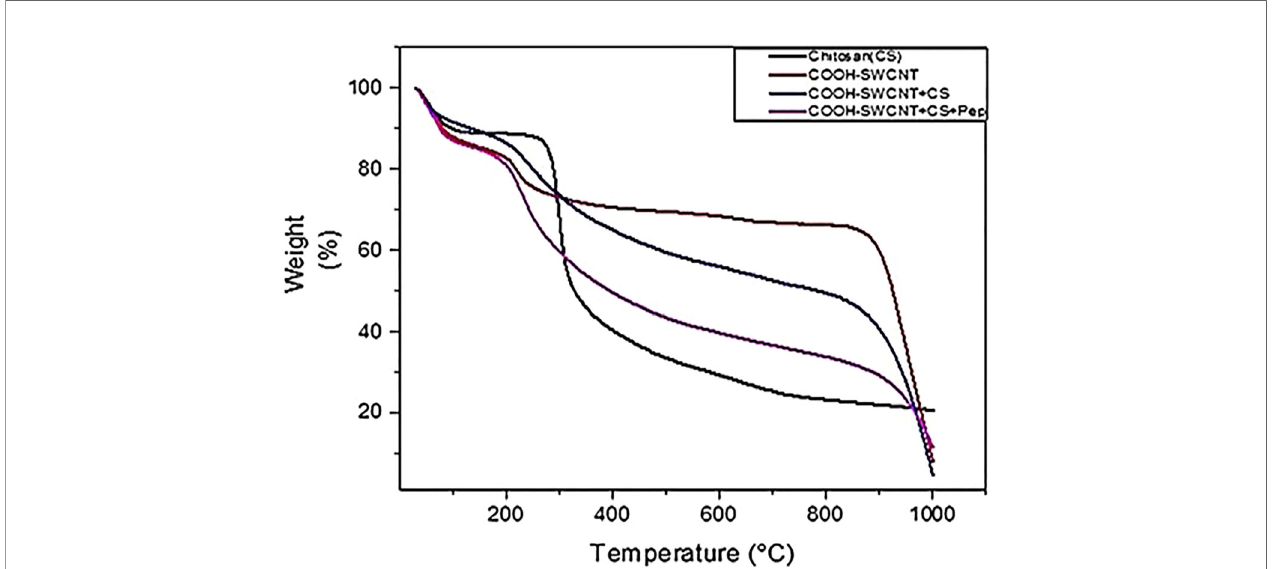
FIGURE 5 | TGA results of CS (chitosan), COOH-SWCNT (single-walled carbon nanotubes), COOH-SWCNTCS (single-walled carbon nanotubes with chitosan), COOH-SWCNTCSPePs (Chitosan-carbon nanotubes with